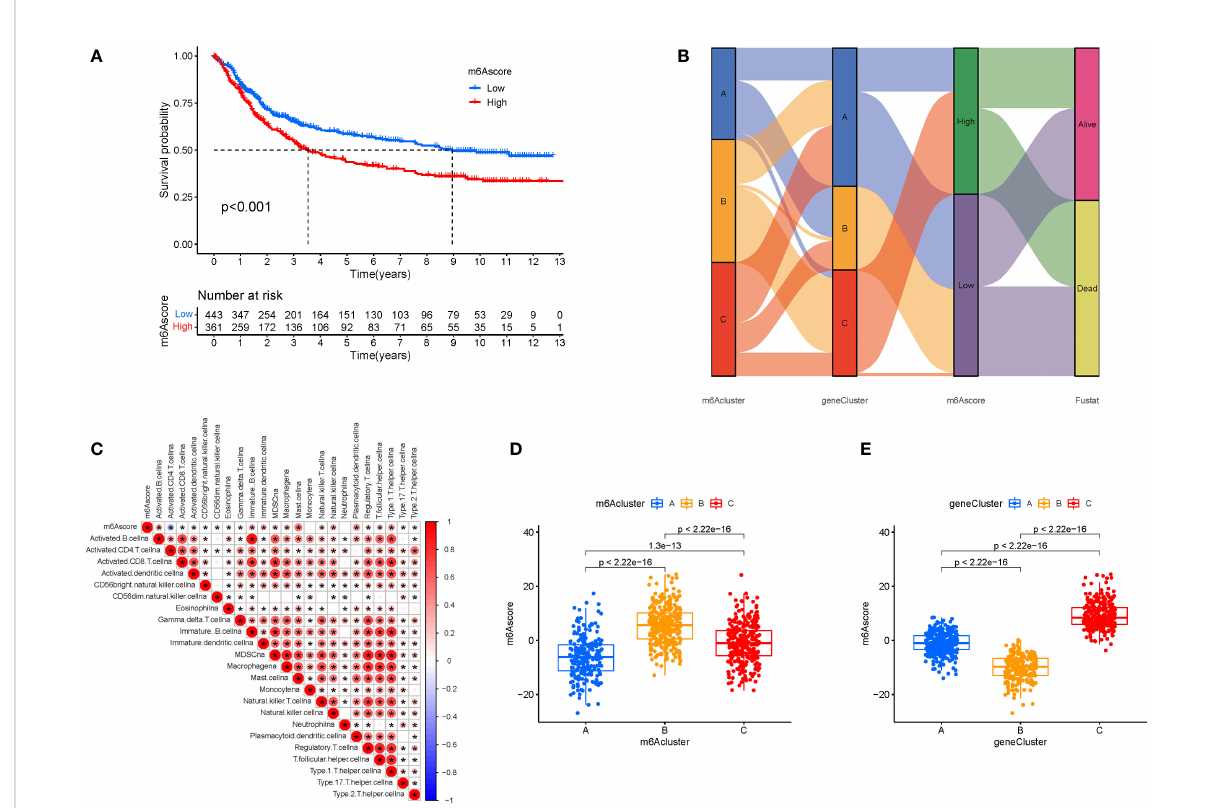
FIGURE 7 M6A Score Construction. (A) Survival (The high-m6Ascore group fared better than the low-m6Ascore group). (B) Ggalluvial plot. (C) Immune cells and prognosis m6A-genes. (D) m6A regulators cluster (The highest m6Ascore was discovered in the m6A regulators cluster B, whereas the lowest m6Ascore was discovered in the m6A regulators cluster A). (E) Gene